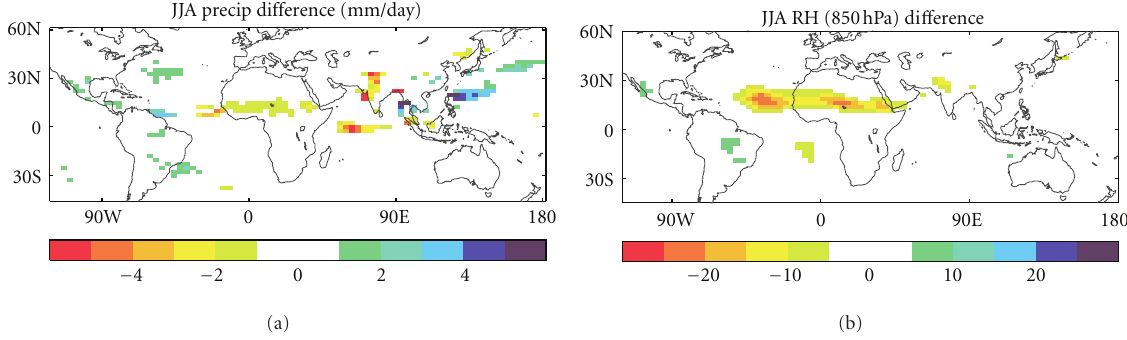
Figure 10: The di ff erence in (a) precipitation (mm/day) and (b) relative humidity (RH, %) in JJA for DEAD relative to CLIM.